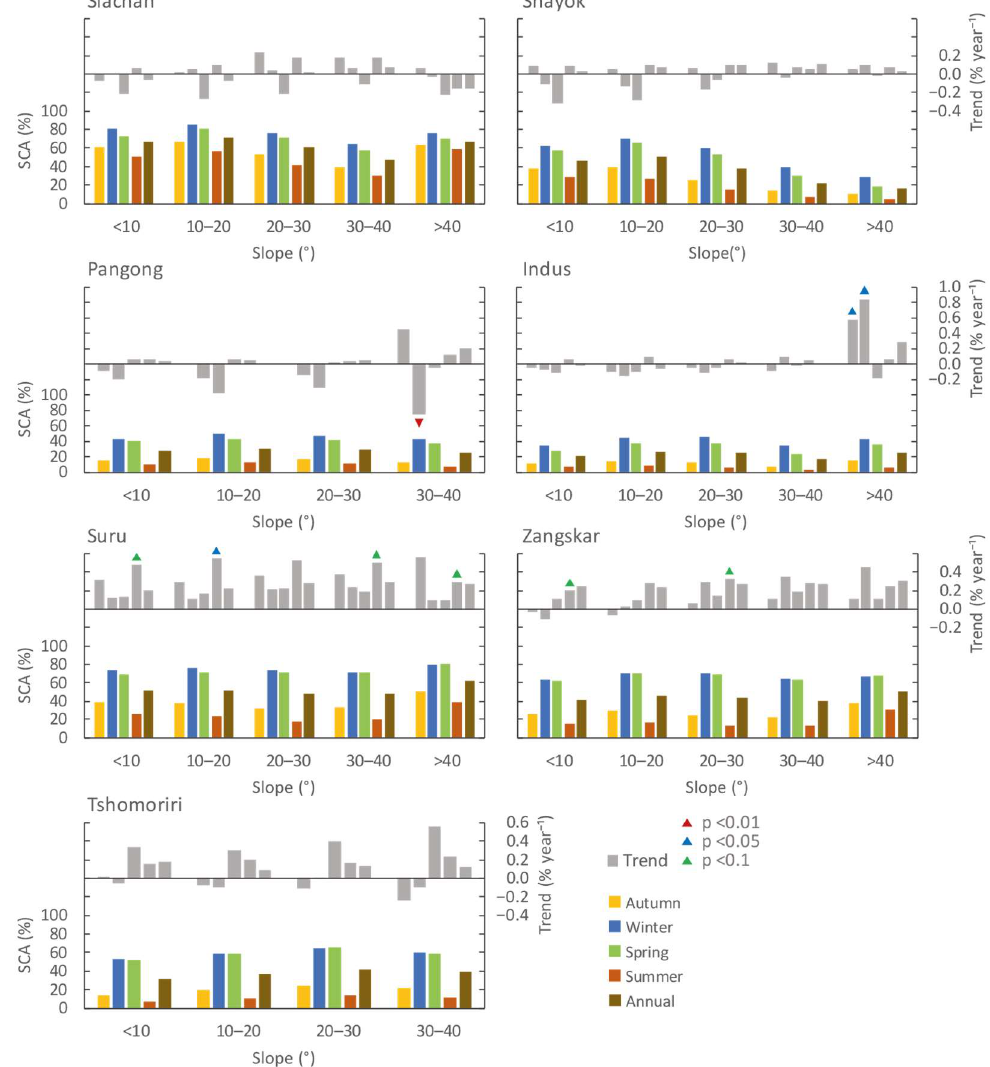
Figure 11. Seasonal MODIS SCA in relation to aspect across all subregions of the study area over the observation period of 2000–2019.